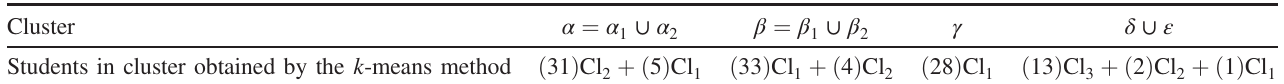
TABLE VIII. Redistribution of students placed in NH -CLA clusters into H -CLA clusters. Cluster Students in cluster obtained by the k -means